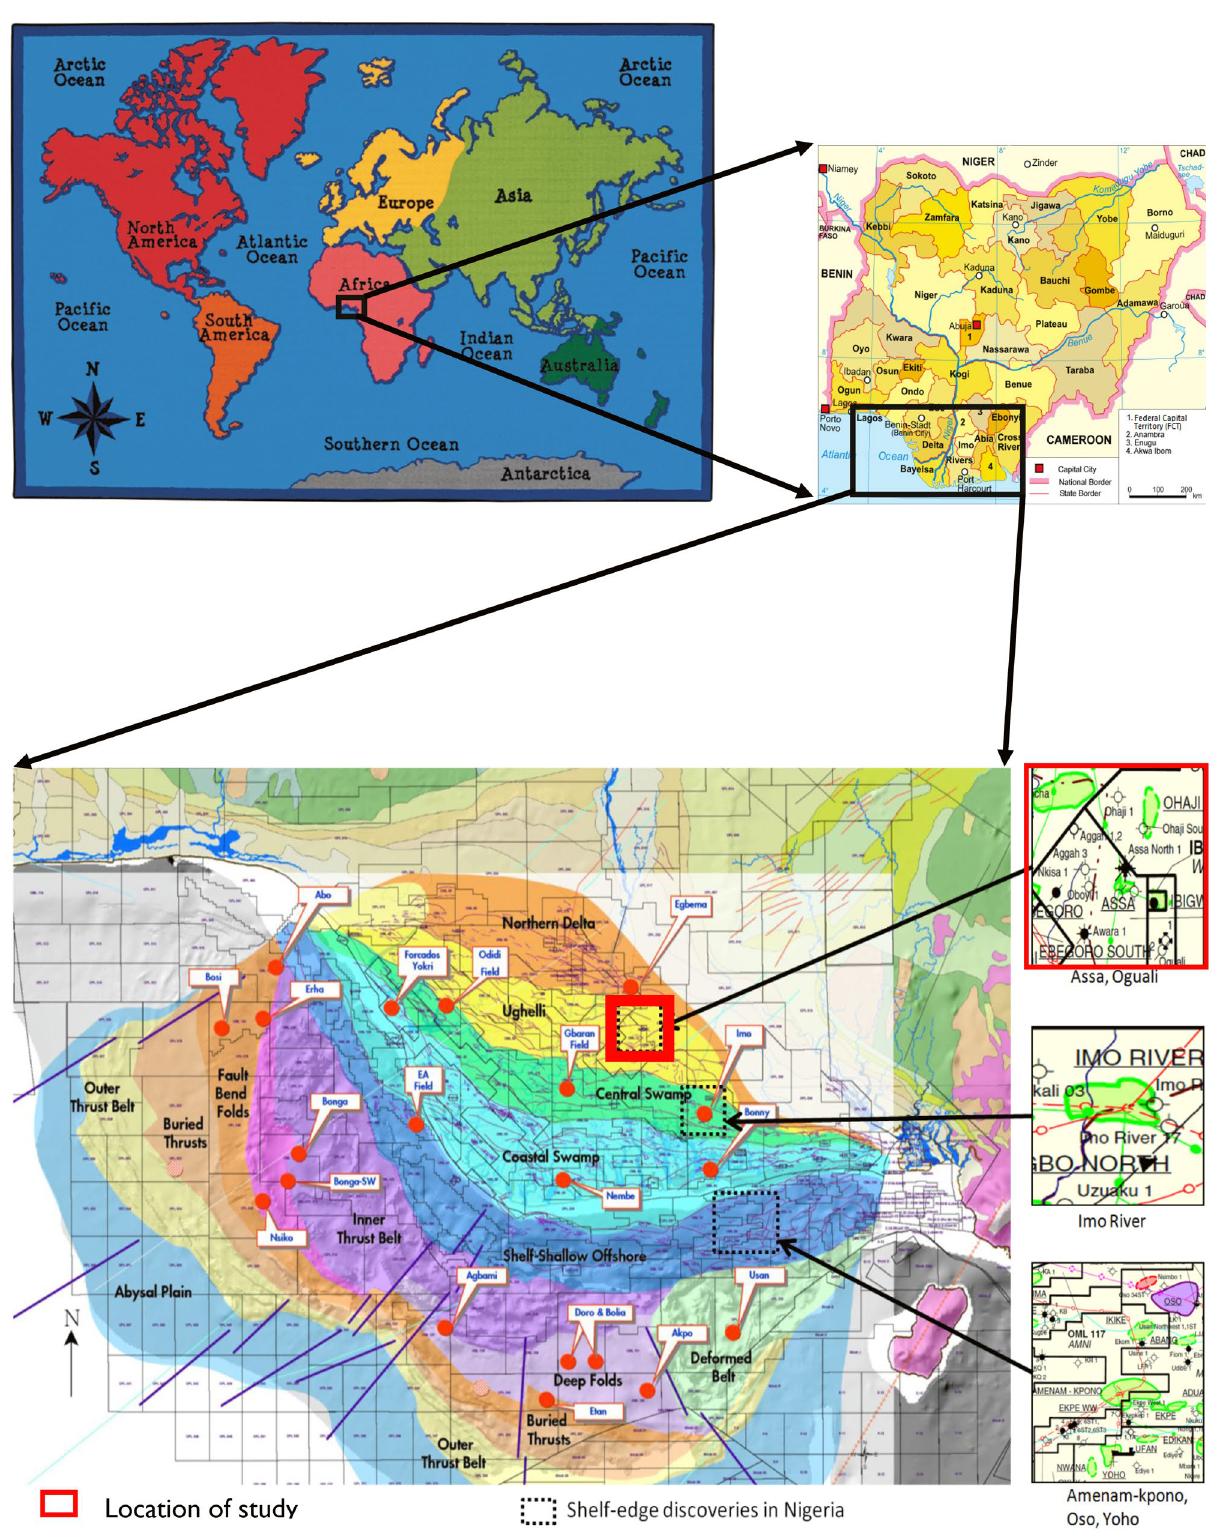
Fig. 1 Location of study area and compiled locations of shelf-edge delta discoveries in structural play segments map of Niger Delta Basin, Nige- ria. Modified after Ejedawe et al.